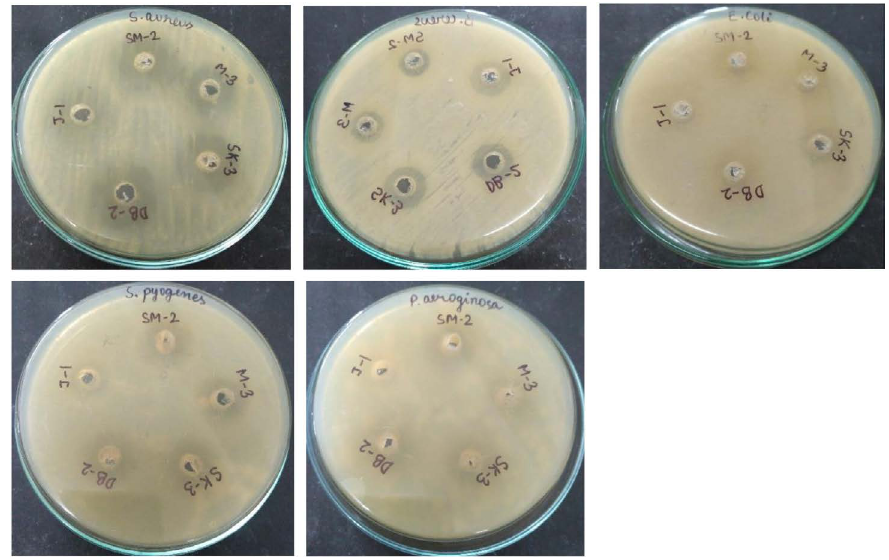
Fig. 8. Inhibitory activity of crude bacteriocin against five pathogenic